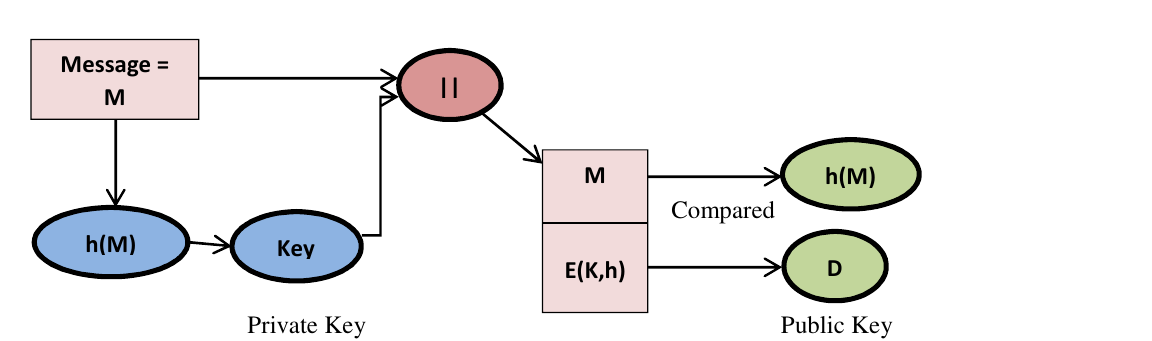
FIG. 4. DIGITAL SIGNATURE USING RSA